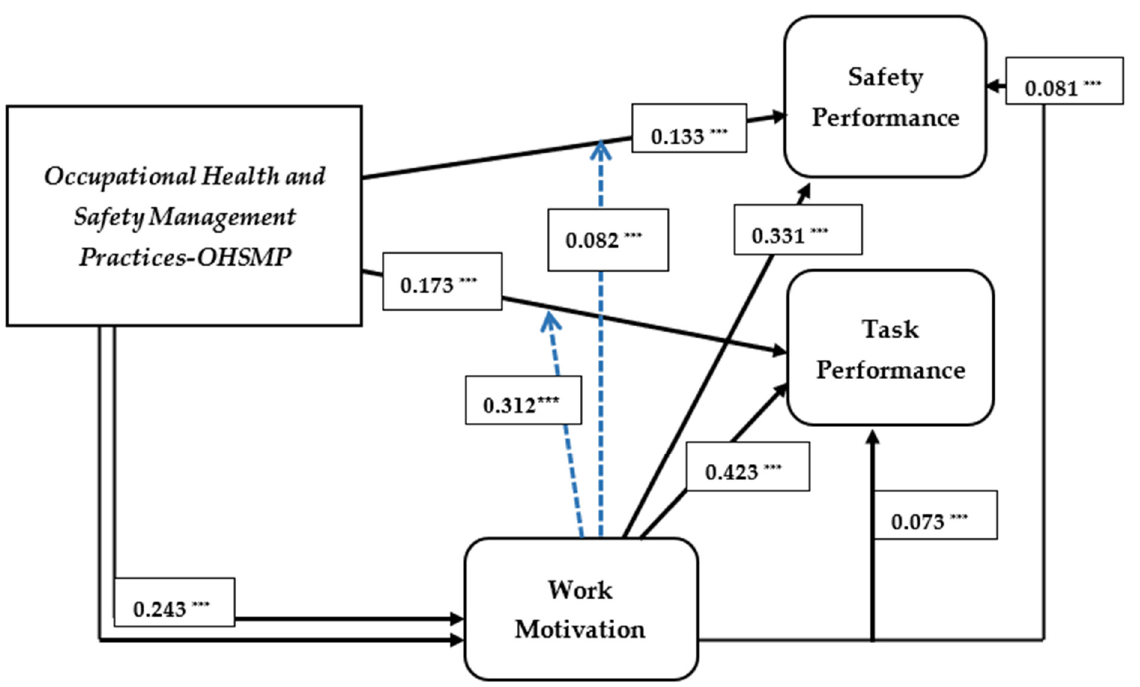
Figure 3. Path Analysis. Note: *** significant at 95% confidence interval.